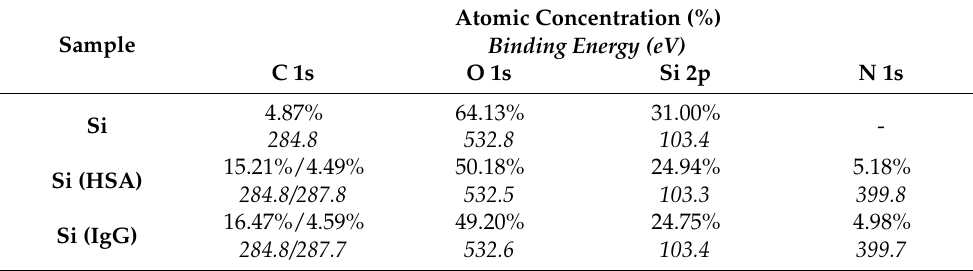
Table 3. Spectral parameters, estimated by XPS, of the porous Si sample before and after the adsorption process using HSA and IgG and a phosphate buffer at pH 7.0.